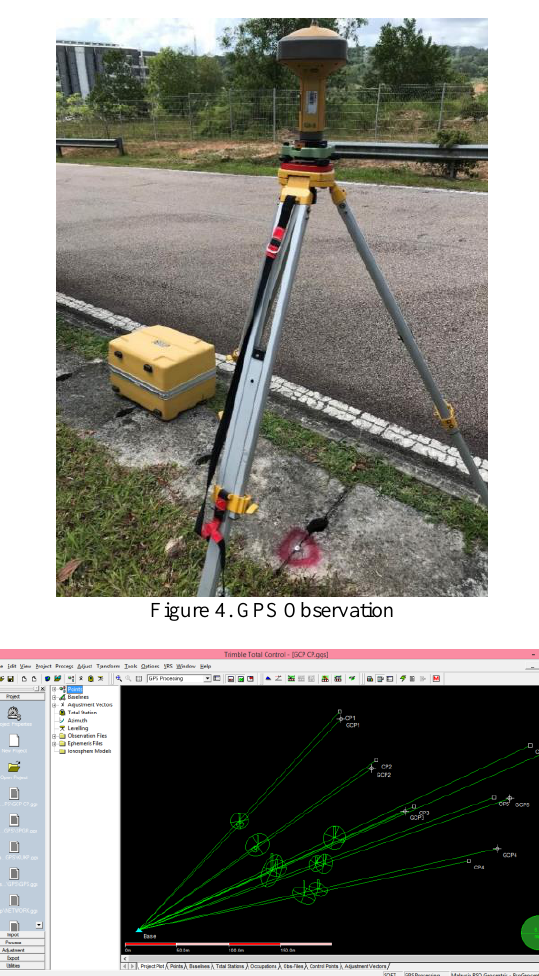
Figure 5. TTC Software during Single Baseline